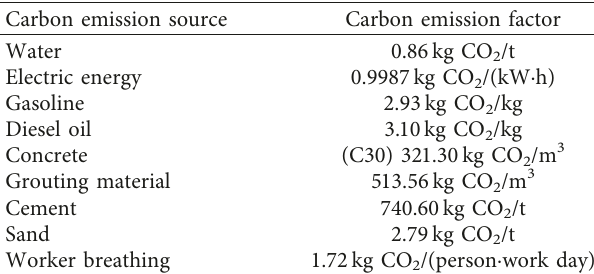
Table 2: Carbon emission